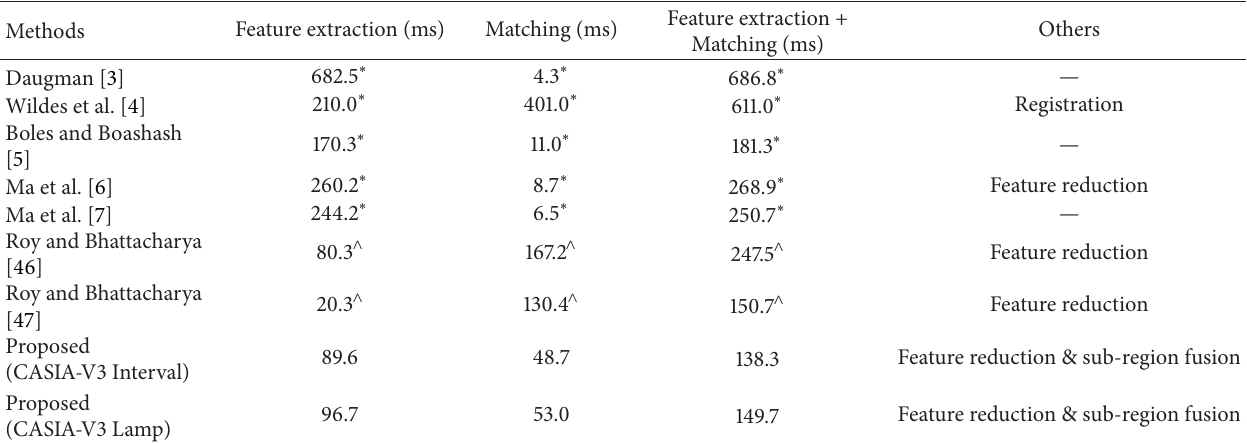
Table 4: Comparison of the computation